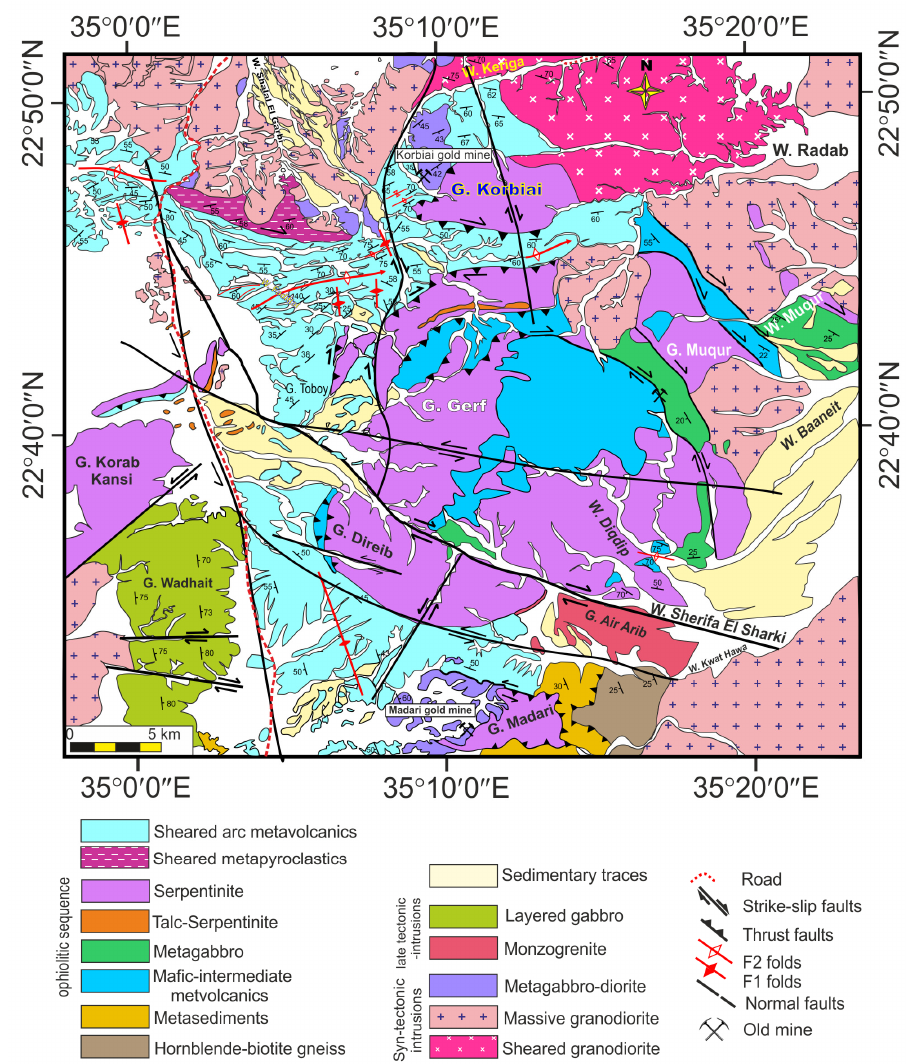
Figure 2. Geological map of the Gerf area based on remote sensing data and field investigations modified after Egyptian Geological Survey and Mining Authority (EGSMA) [44].